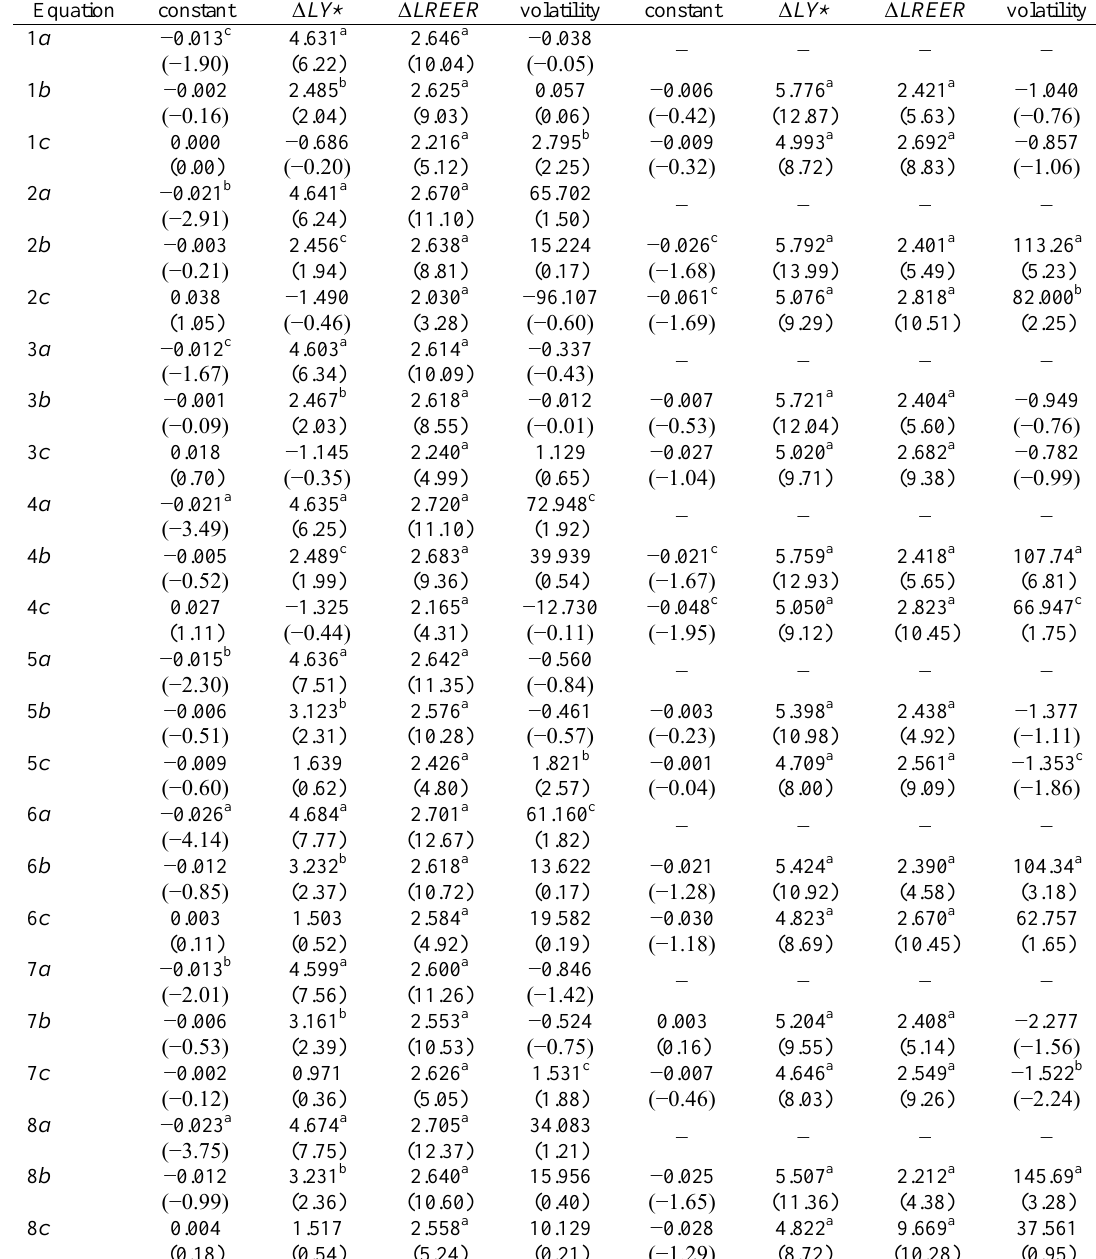
Table 6 : Exports and exchange rate volatility: